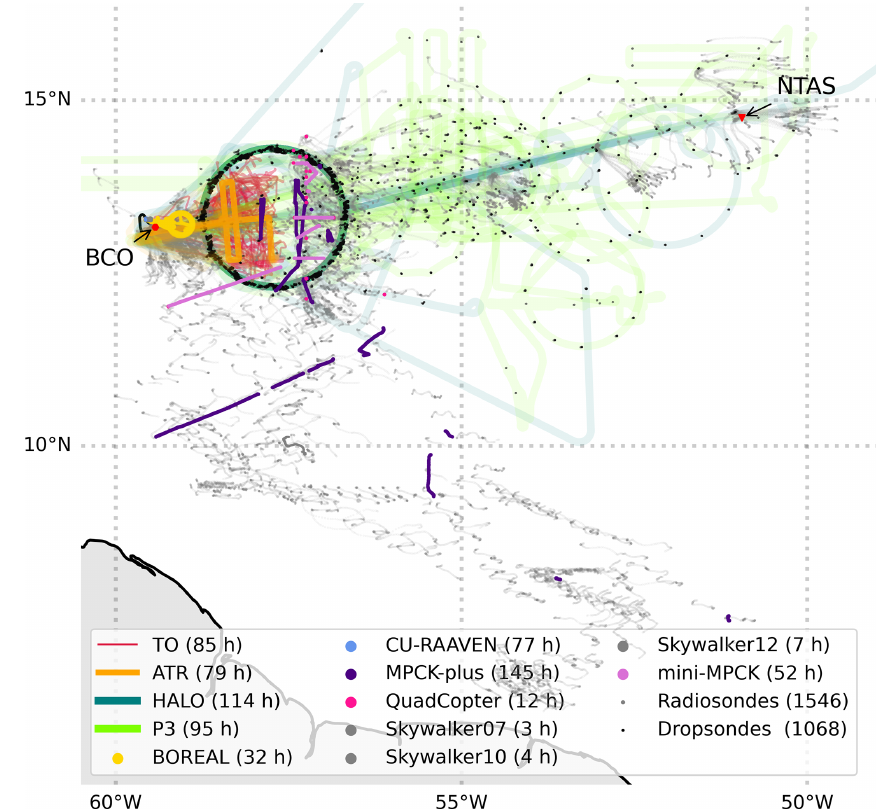
Figure 2. Heat map showing distribution of airborne-platform tracks, colored (with transparency) by platform. Sonde trajectories are shown by trail of dots, with the slower ascent of the radiosondes leading to greater horizontal displacements leading to tracks resembling gray whiskers. The legend includes the flight time (defined as the period spent east of 59 ◦ W and west of 45 ◦ W to exclude ferries) and number of soundings. Radiosondes ascents and descents with valid data are treated as